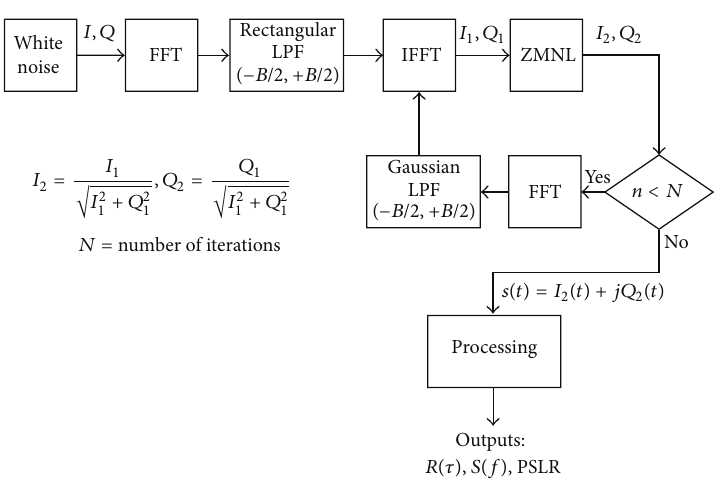
Figure 1: Block diagram of the iterative